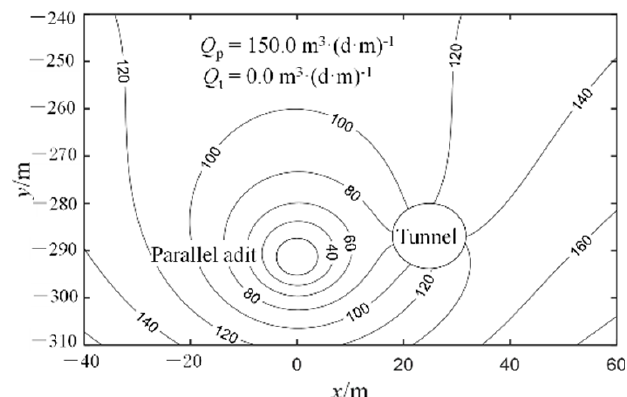
Figure 13. Pressure head contour around the tunnel and parallel adit.